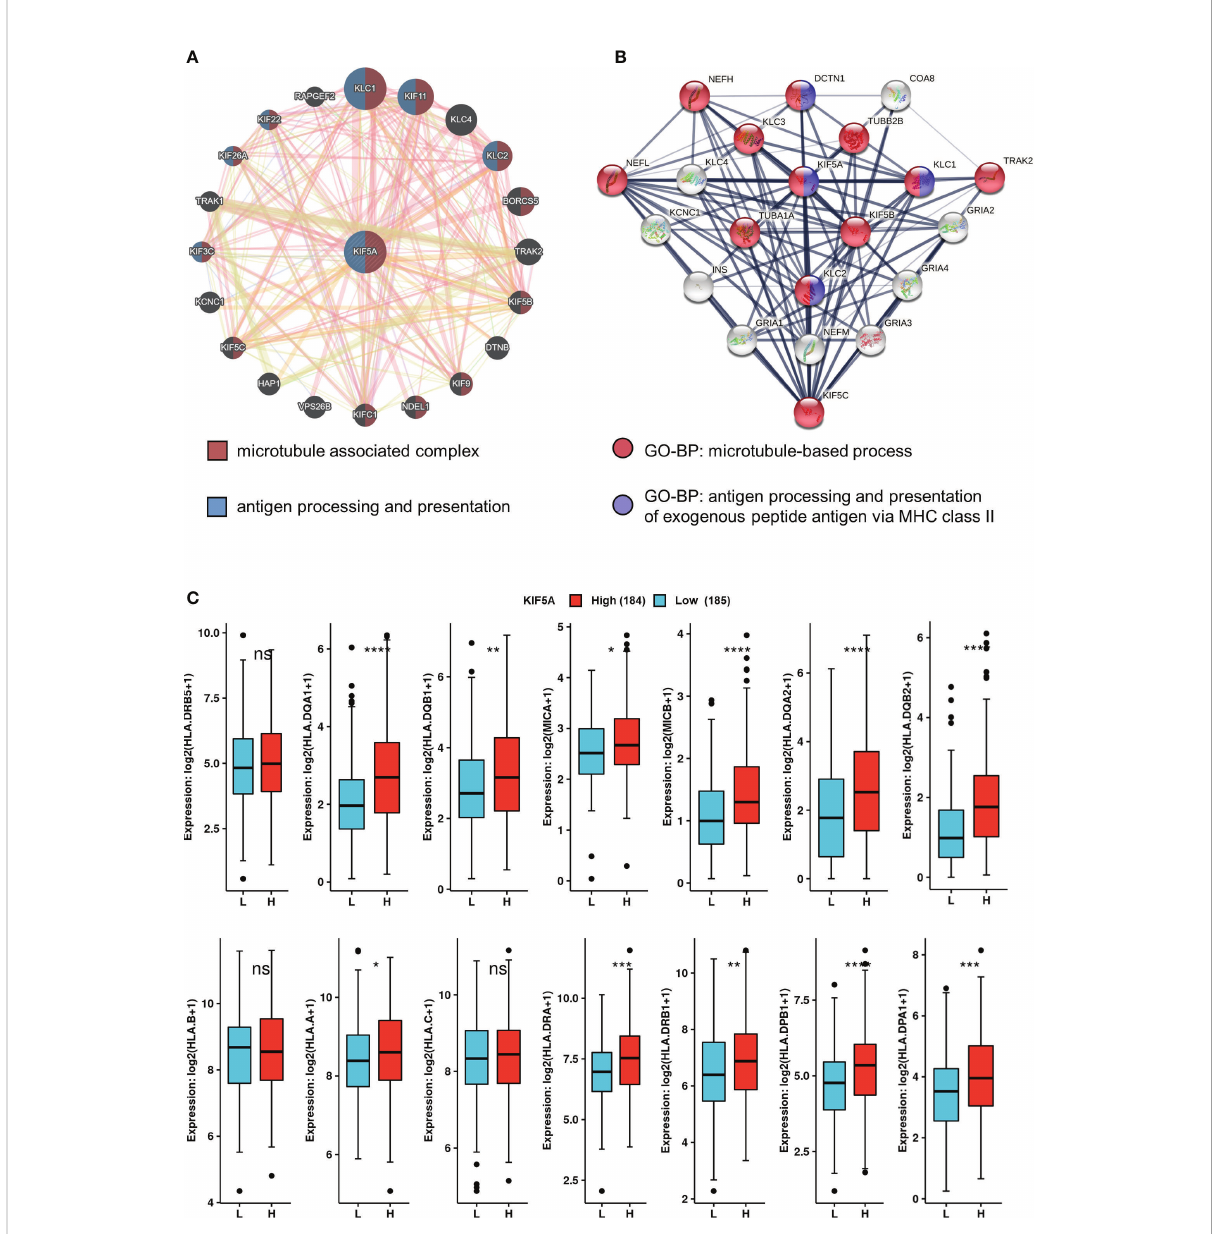
FIGURE 4 KIF5A-Related network and potential biological function. (A) GGI network of KIF5A and its potential biological functions. (B) PPI network of KIF5A and its potential biological functions. (C) Comparison of antigen presentation-related markers between two groups. **** p < 0.0001, *** p < 0.001, ** p < 0.01, * p < 0.05, ns not signi fi